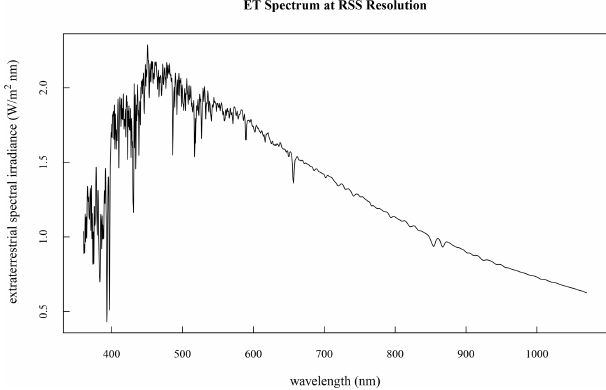
Figure 3. Extraterrestrial solar spectrum used for this paper, using the RSS slit function applied to a Kurucz high-resolution calculated ET solar spectrum and then scaled to the Gueymard low-resolution ET solar spectrum, which is regarded as our best estimate of abso- lute irradiances.